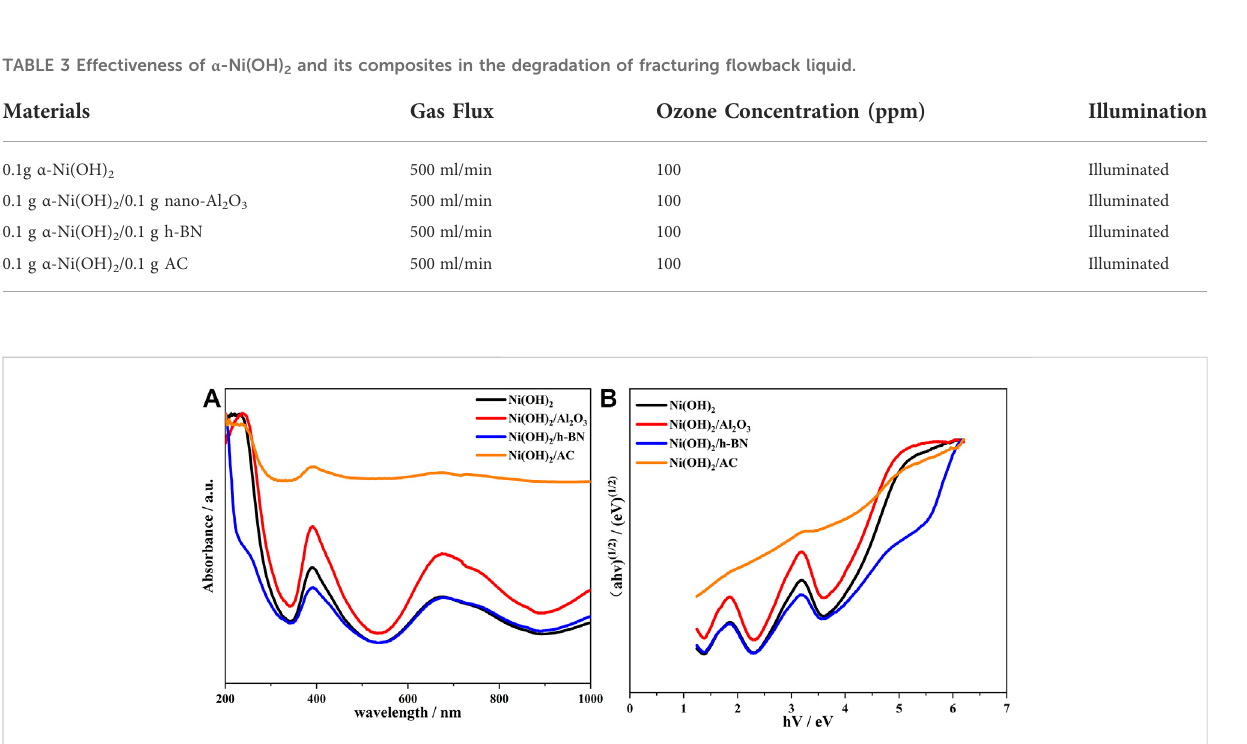
FIGURE 7 (A) UV – vis diffuse re fl ectance spectroscopy results for different samples; and (B) band gaps of different